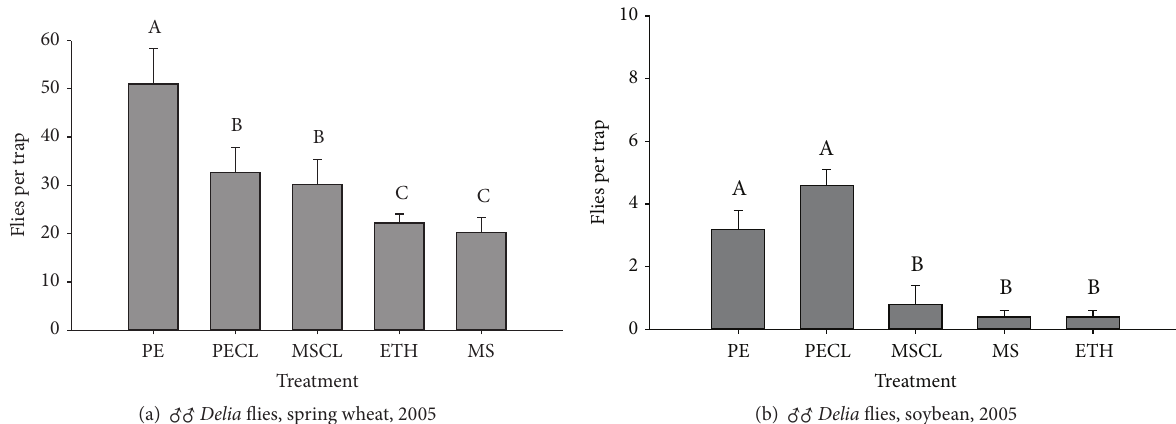
Figure 6: Mean number ( ± SE) of male Delia flies captured near Brookings, SD, on sticky traps baited with a volatile attractant. (a) Spring wheat, Jun 15–17, 2005 (test #3). (b) soybean, Jul 14–16, 2005 (test #6). PE = 2-phenylethanol, MS = methyl salicylate, and ETH = ethanol (control), each at 100mg on a cotton roll; PECL = 2-phenylethanol and MSCL = methyl salicylate, each at 2 mg on a controlled-release lure. For each graph, bars without the same letter above them indicate significant differences between means.